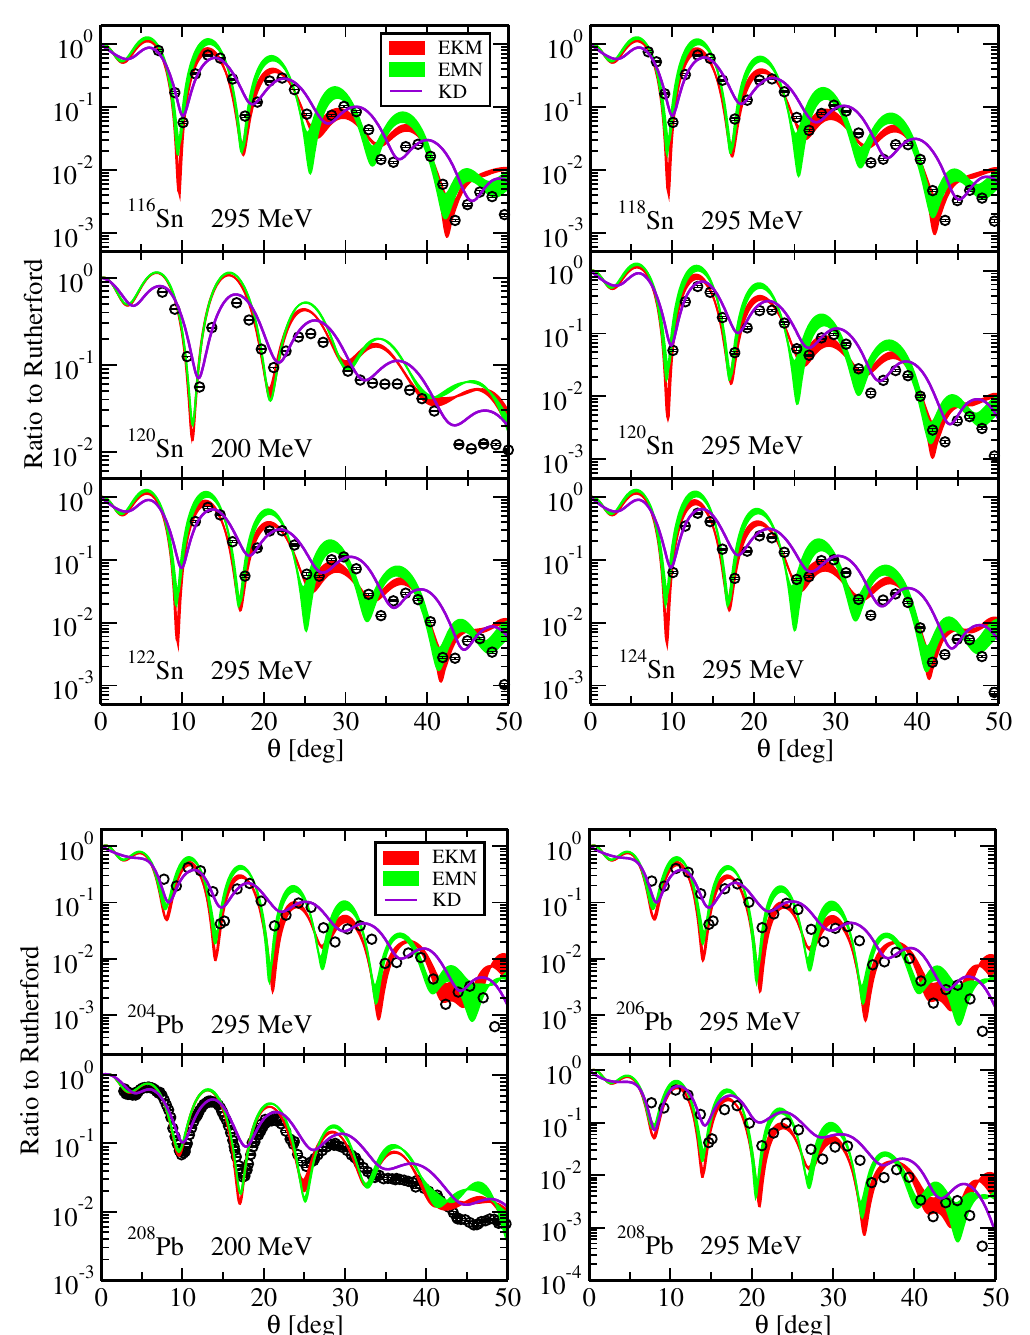
Figure (2) (Upper panel) The same as in Fig. 1 for Sn isotopes: 120 Sn at E = 200 MeV and 116 , 118 , 120 , 122 , 124 Sn at E = 295 MeV. Experimental data from Refs. [13, 14]. (Lower panel) The same as in Fig. 1 for Pb isotopes: 208 Pb at E = 200 MeV and 204 , 206 , 208 Pb at E = 295 MeV. Experimental data from Refs. [13,